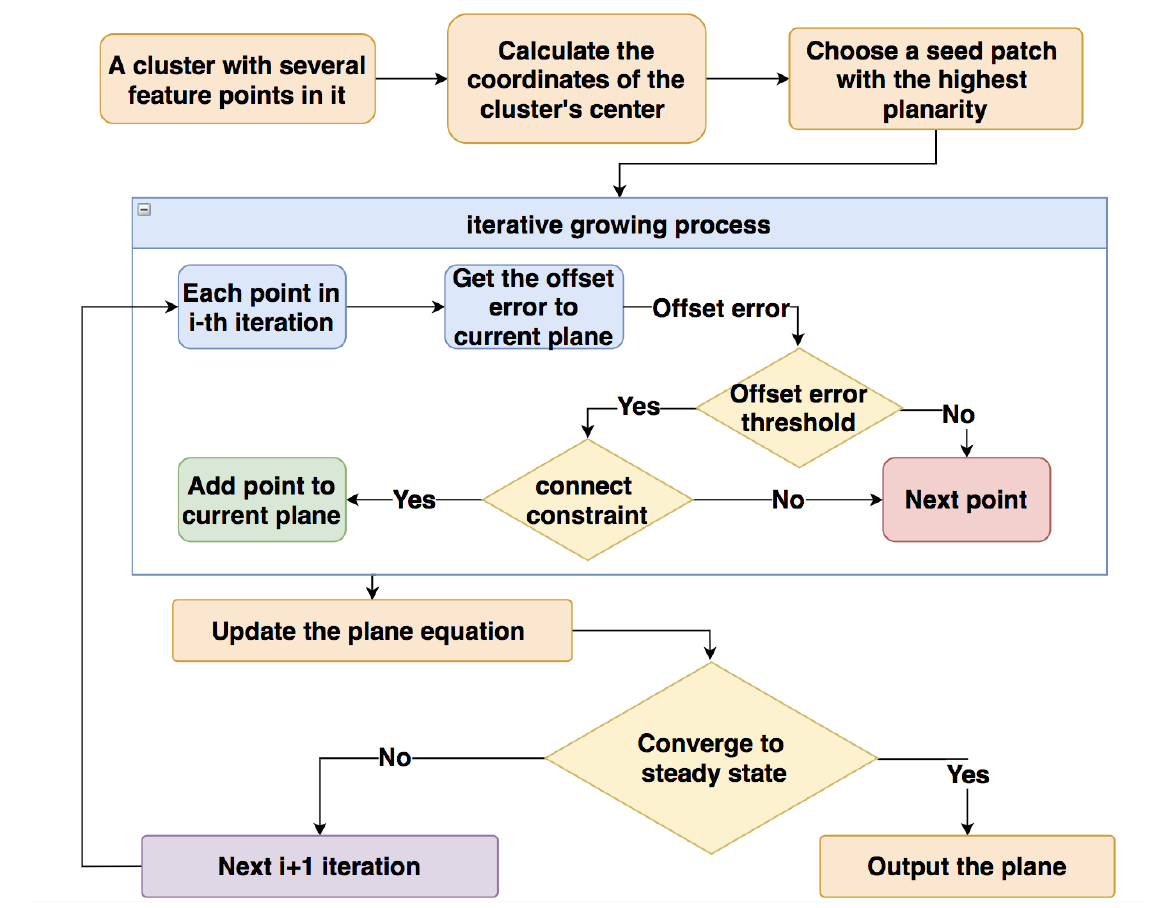
Figure 6. Region growing